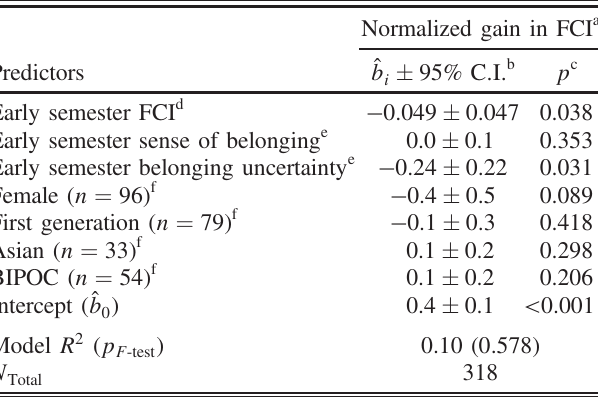
TABLE V. Normalized gain in FCI regression